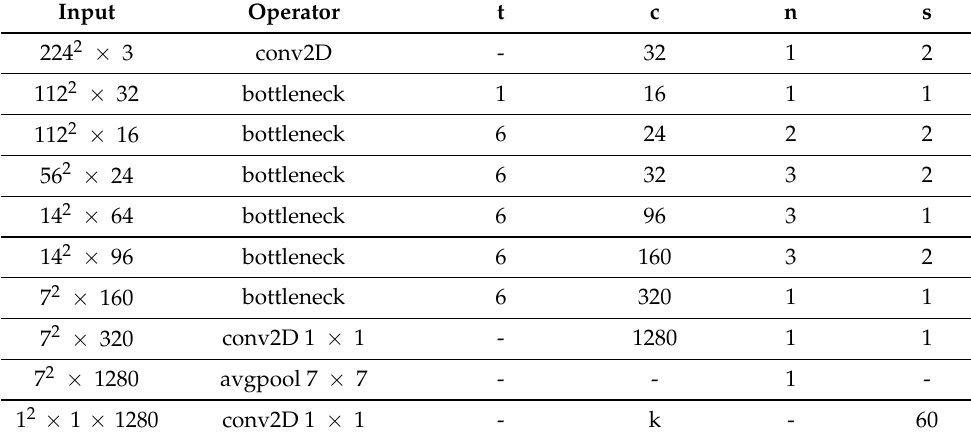
Figure 3. Training of a pre-trained model using transfer learning and testing in real-world scenarios. Table 1. The overall encoder architecture. t is the expansion factor, c is the number of output channels, n is the number of repeated layers and s is the